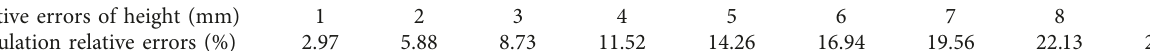
Table 1: The relative errors of height changes.